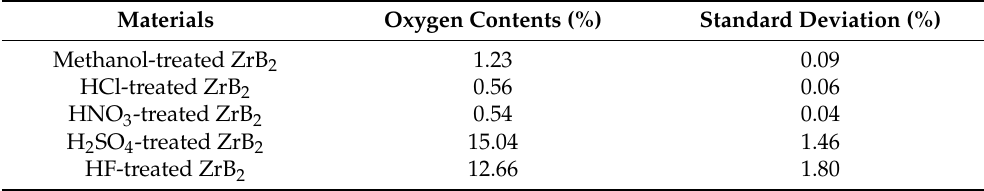
Table 1. The oxygen contents of as-prepared of ZrB 2 and acid-treated ZrB 2 .